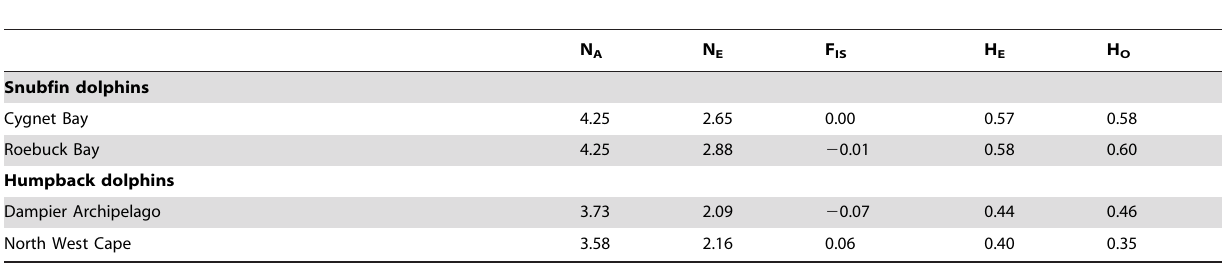
Table 1. Microsatellite characteristics for snubfin and humpback dolphins.